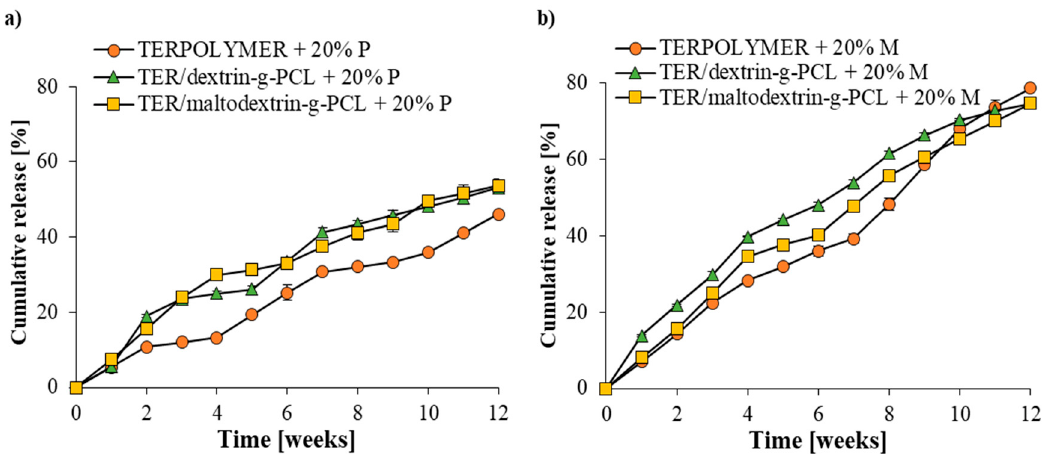
Figure 6. Cumulative release of pendimethalin ( a ) and metazachlor ( b ) from microspheres into water. The error bars are smaller than the symbols where they are not shown.